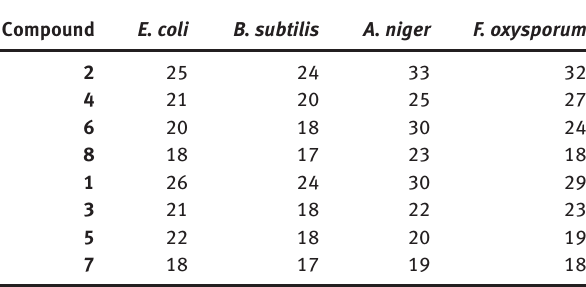
Table 3 Minimum inhibitory concentration ( μ g ml -1 ) of the ligands and their complexes.